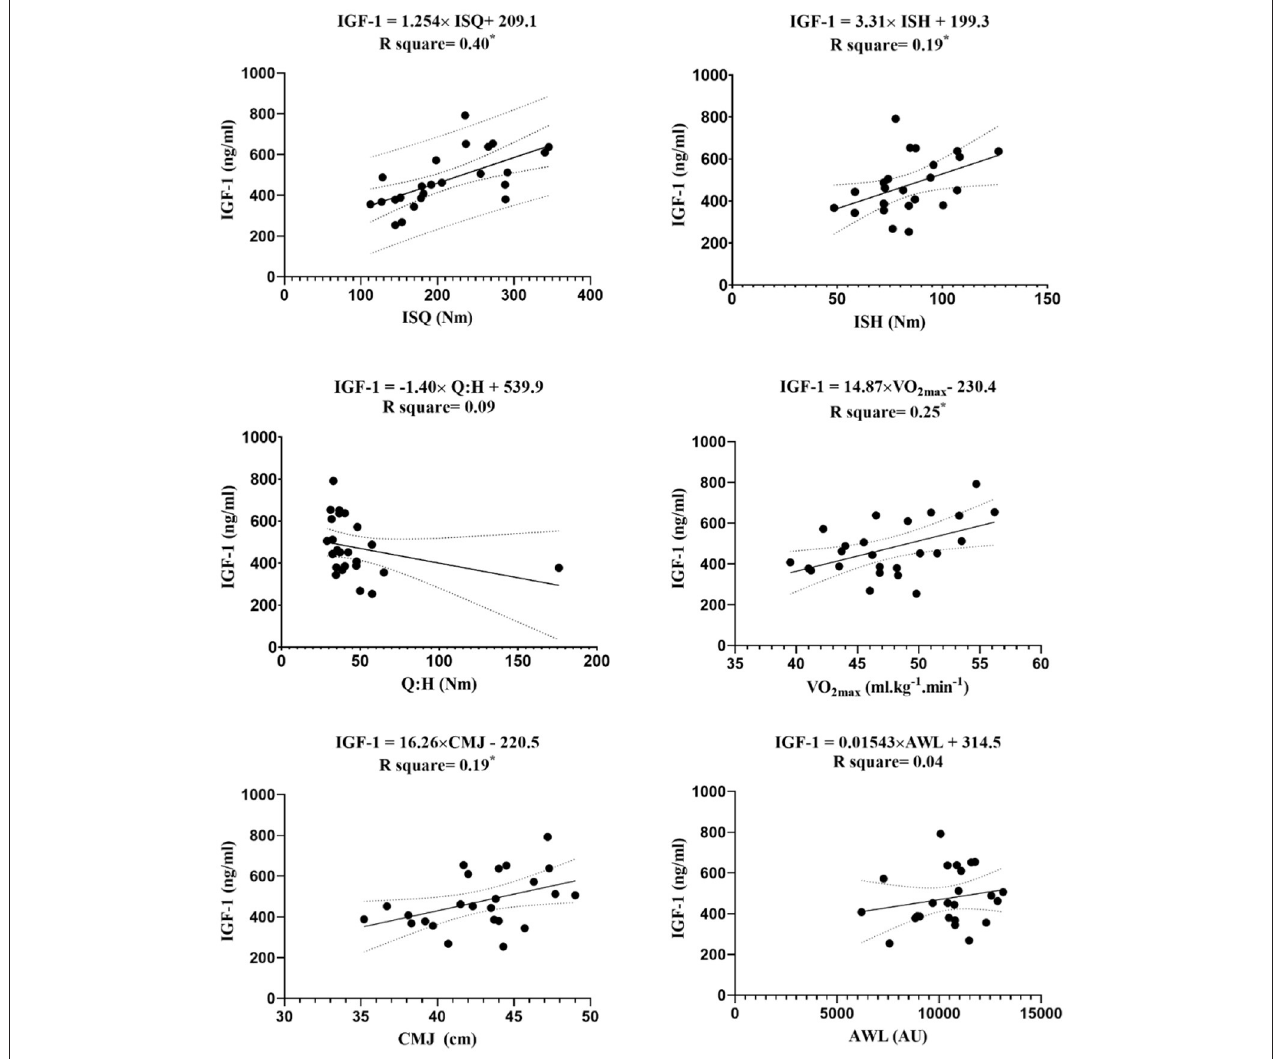
FIGURE 3 | Regression analysis to explain fitness levels and AWL (the average of the three stages) with IGF-1, insulin-like growth factor-1; ISH, isometric muscular strength of the hamstring muscles; ISQ, isometric muscular strength of the quadriceps muscles; H:Q, the strength of isometric quadriceps to hamstring ratio; VO 2max , maximal oxygen uptake; CMJ, countermovement jump; AWL, accumulated workload; Nm, Newton meter; AU, arbitrary unit. * Significant differences p ≤